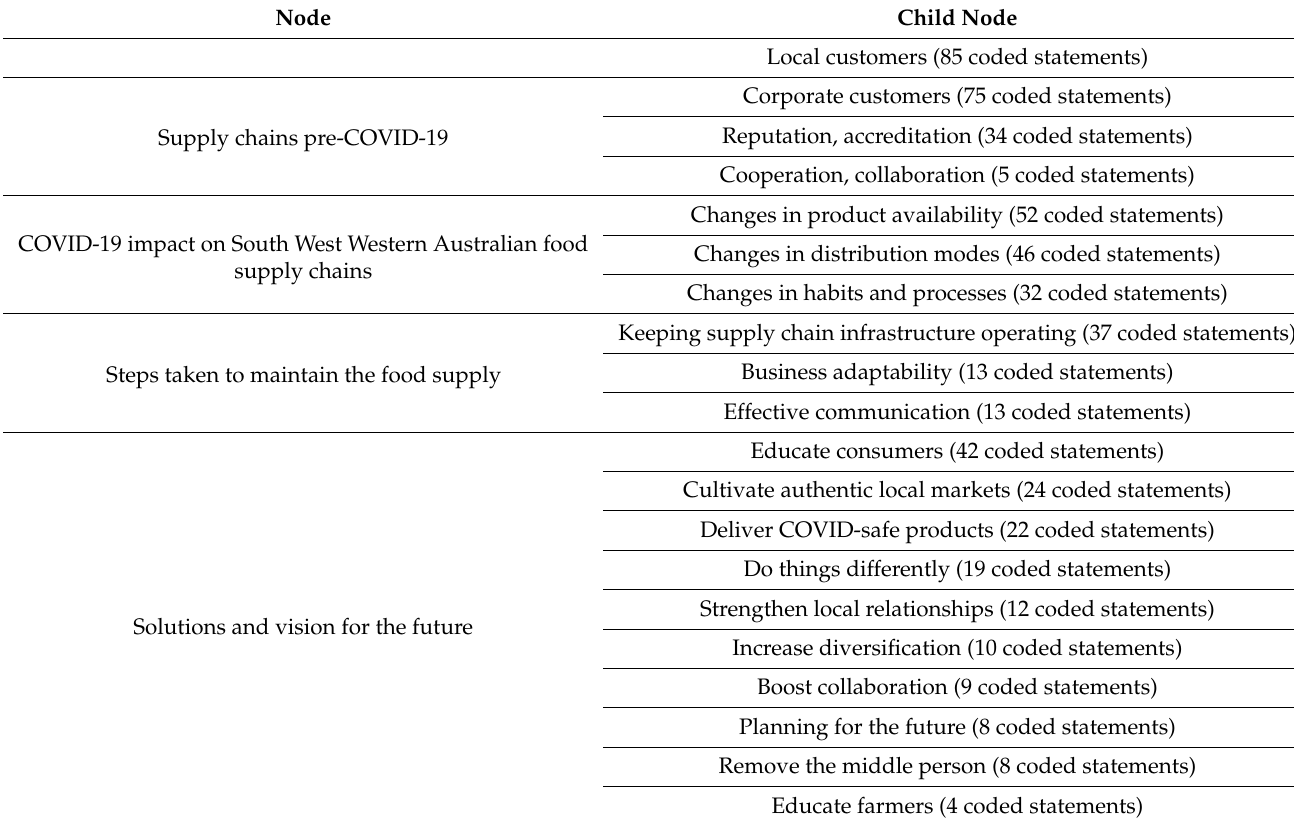
Table 1. Nodes determined during data